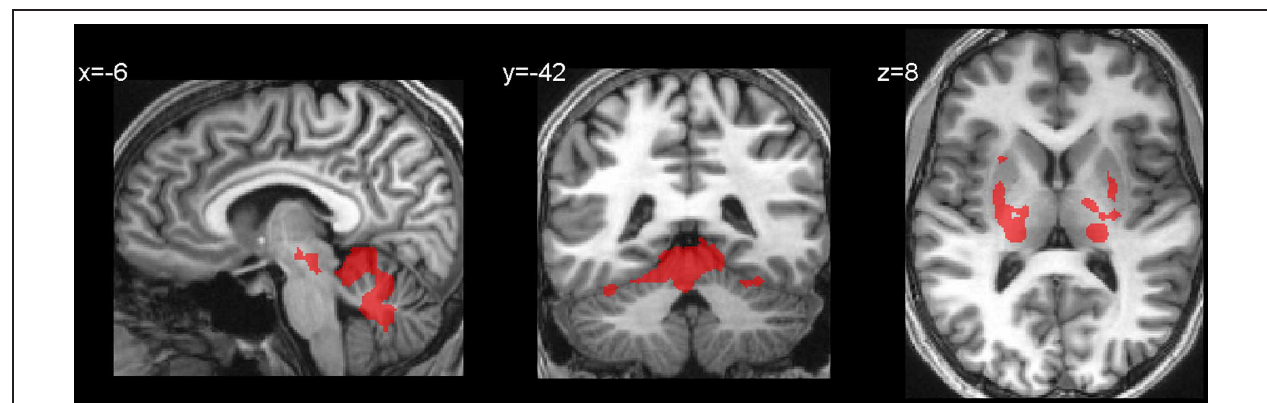
Frontiers in Behavioral